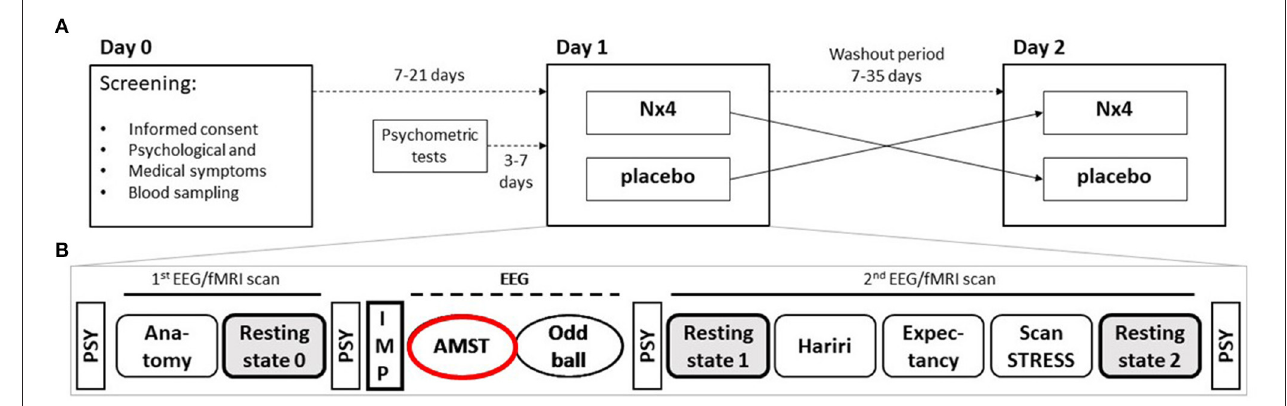
FIGURE 1 | Two sequence, two period cross-over Study design of NEURIM study. (A) Overall design with screening on day 0 and the two cross-over sessions on day 1 and 2 with a 7–35 days washout period in between. (B) Detailed procedures on each day, 1 and 2. During the first fMRI scan an anatomical scan and a baseline resting-state measurement were acquired, followed by the intake of the IMP. Afterwards, two EEG paradigms (AMST and Oddball) were recorded. The second fMRI scan consisted of three task measurements, the Hariri paradigm, the Expectancy paradigm, and the ScanSTRESS paradigm, and two resting-state sequences. Psychometrics were measured several times. AMST, Attention Modulation by Salience Task; EEG, Electroencephalography; IMP, Investigational Medicinal Product; MRI, Magnetic Resonance Imaging; PSY, psychometrics.